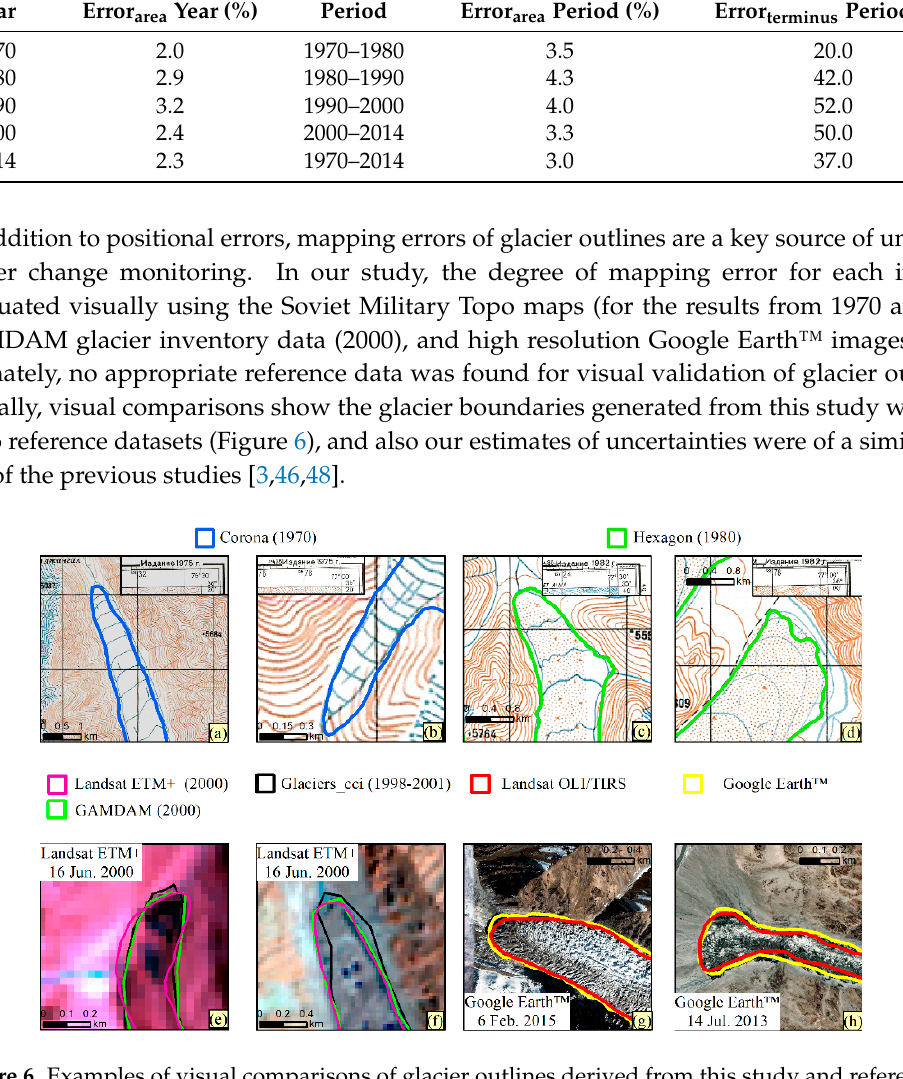
Figure 6. Examples of visual comparisons of glacier outlines derived from this study and references such as Soviet Military Topo maps ( a – d ), Glacier Area Mapping for Discharge from the Asian